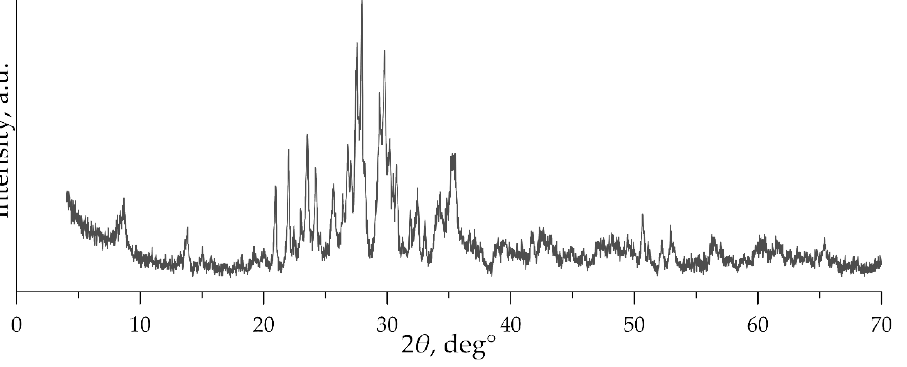
Figure 2. A typical diffraction pattern used in this study.